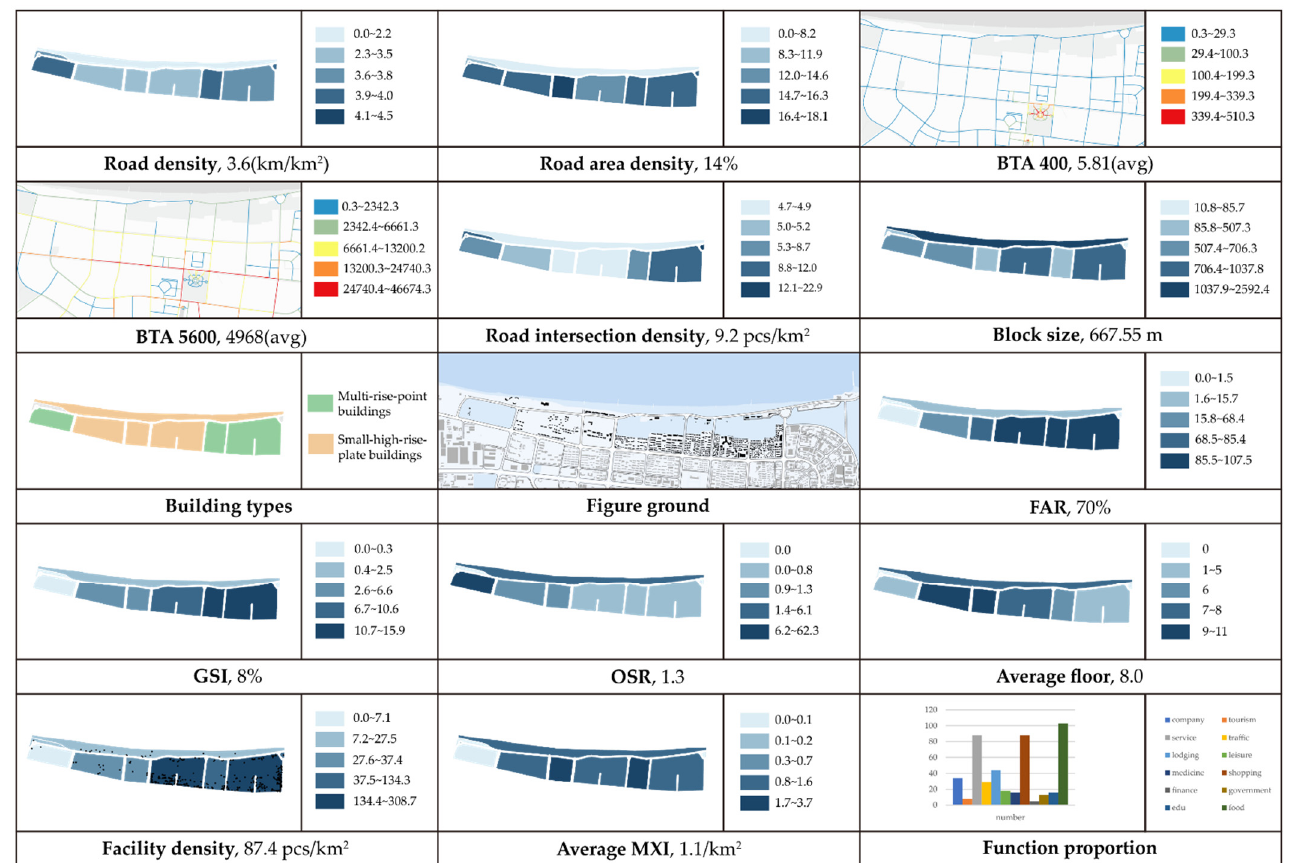
Figure 17. The analysis result of the Jinshatan area, Yantai.